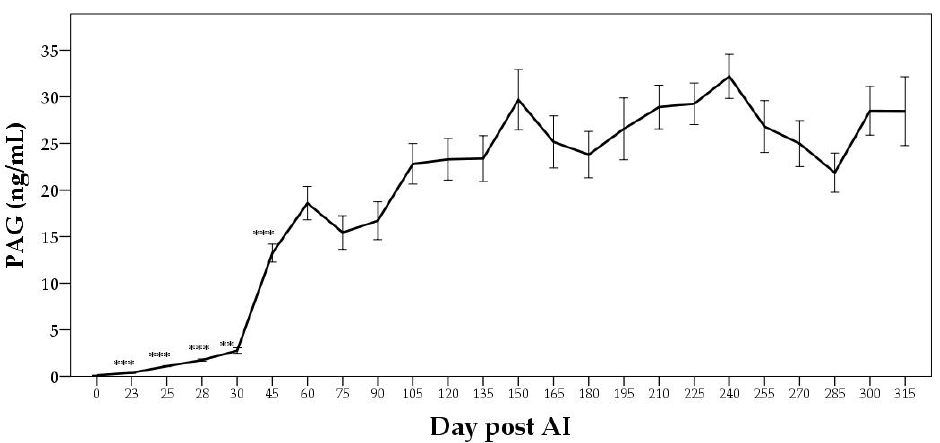
Figure 5. Pregnancy-associated glycoprotein (PAG) plasma profile during pregnancy in buffalo cows. *** p < 0.001, ** p < 0.01 versus previous day. Adapted from Barbato et al. [116].